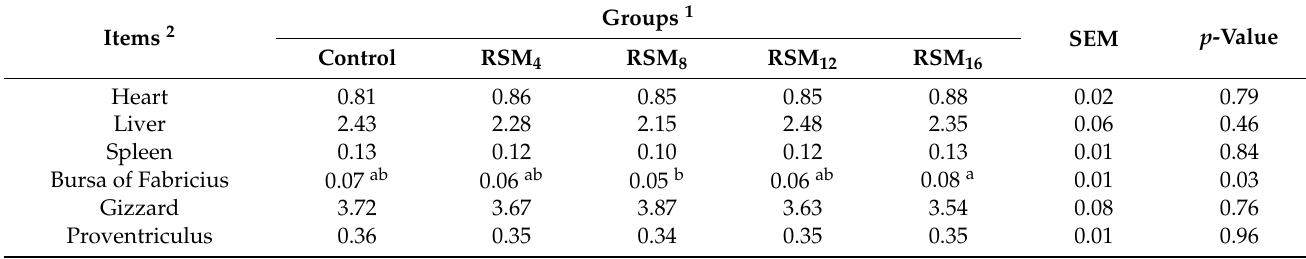
Table 5. Effects of increasing dietary levels of rapeseed meal on the relative weights of visceral organs of geese at 70 d of age.